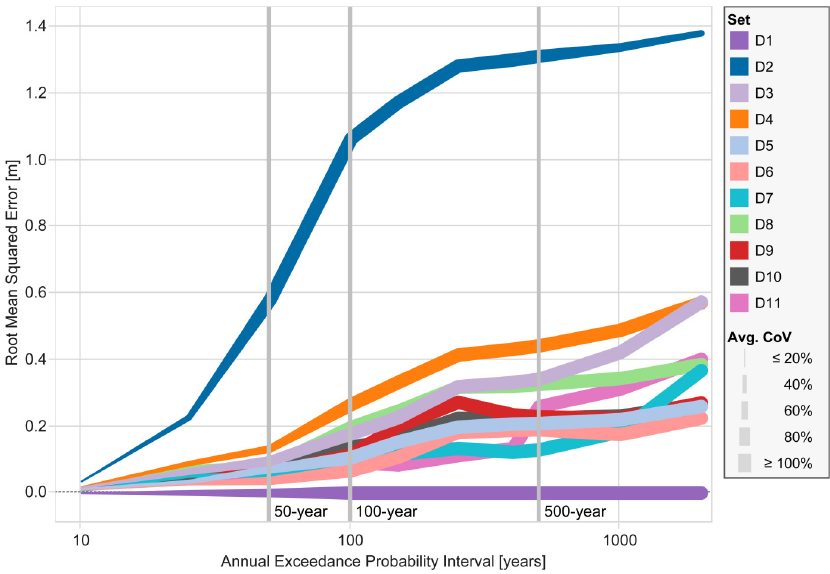
Figure 7. Average bias and variance by exceedance interval (HSDRRS Only).